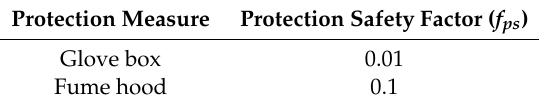
Table 3. Protection safety factors